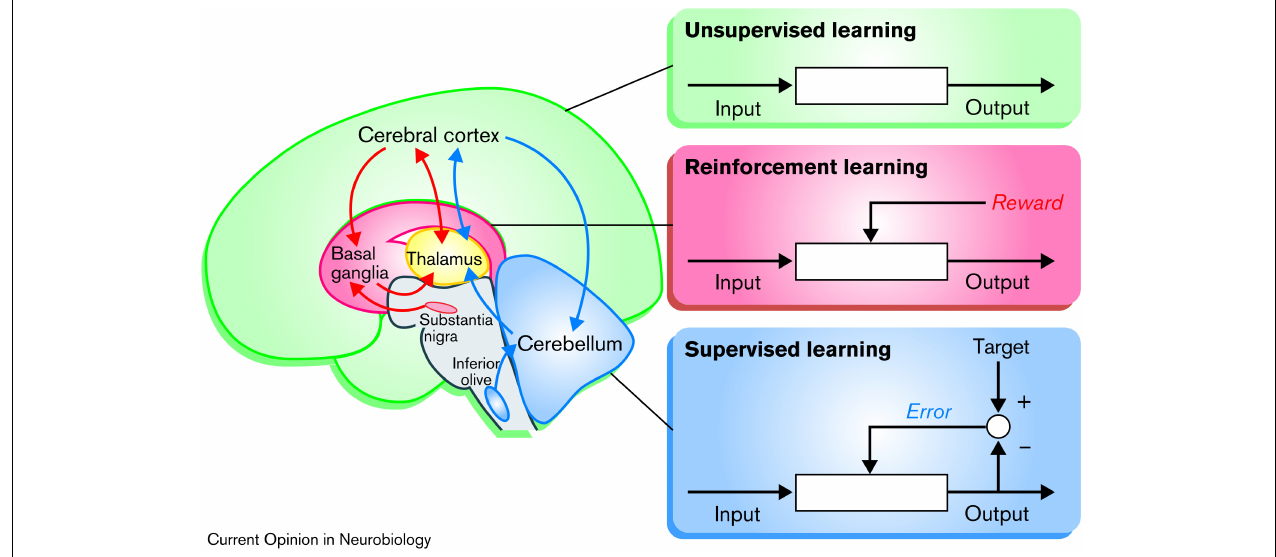
FIGURE 3 | Schematic illustration showing the three different types of learning: According to this model, the basal ganglia are specialized for reinforcement learning, based on rewards in the form of dopamine signaling. The cerebellum is specialized for “supervised learning,” which adjusts the output based on movement error, independent of reward. Finally, the cerebral cortex is specialized for unsupervised “Hebbian” learning, which, might be modulated by inputs from the basal ganglia. Reprinted from Doya (2000) with permission.